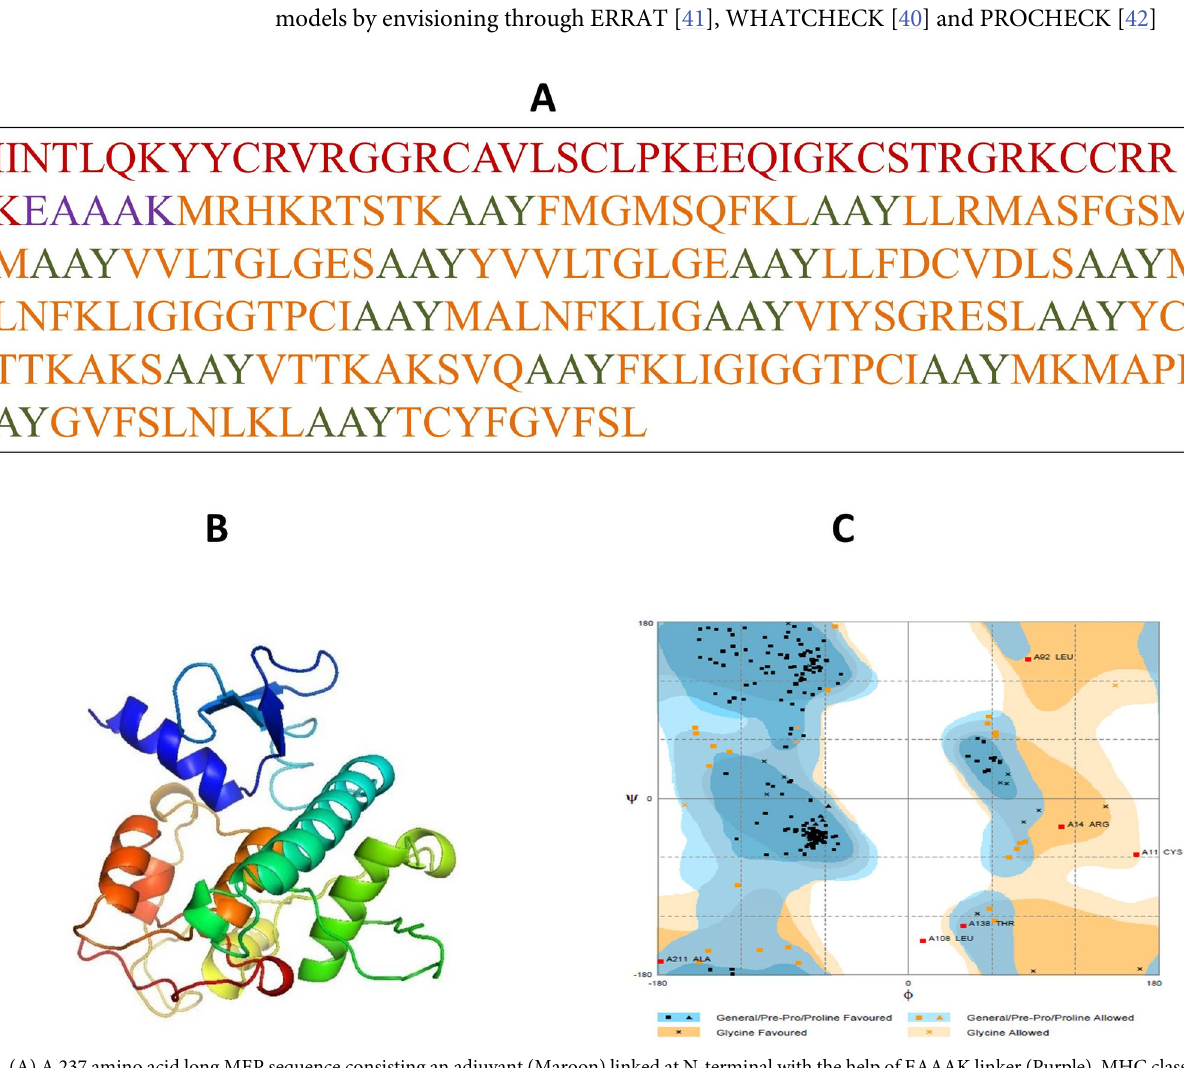
Fig 3. (A) A 237 amino acid long MEP sequence consisting an adjuvant (Maroon) linked at N-terminal with the help of EAAAK linker (Purple). MHC class I & II epitopes (orange) are joined by AAY linkers (Green). (B) The predicted three- dimensional structure of the MEP vaccine construct. (C) Ramachandran plot analysis of MEP structure where 86.0% 11 of residues present in the most favourable